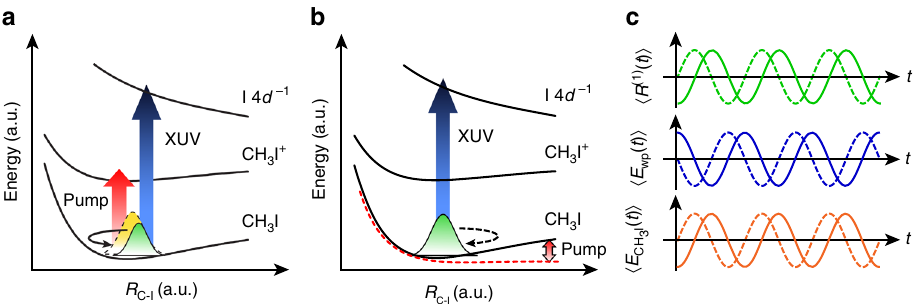
Fig. 1 Generation of vibrational wave packets by intense laser fi elds. Schematic illustration of mechanisms of vibrational wave packet generation along the C – I stretching mode in the electronic ground state of CH 3 I. An intense near-infrared (NIR) pump pulse initiates wave packet motion by a R -selective depletion and b bond softening, which is subsequently probed by extreme ultraviolet (XUV) absorption. The yellow curve in a depicts the equilibrium vibrational probability density, whereas the green curves in both a , b represent the vibrational probability density of the wave packet launched by the intense laser fi eld. c shows the subsequent time-dependent position of the vibrational wave packet h R ð 1 Þ ð t Þi , its XUV transition energy h E wp ð t Þi , and the spectral fi rst-moment signal h E ð Þi . The solid and dashed lines correspond to the trajectories for vibrational wave packets induced by R -selective depletion and CH 3 I t bond softening,